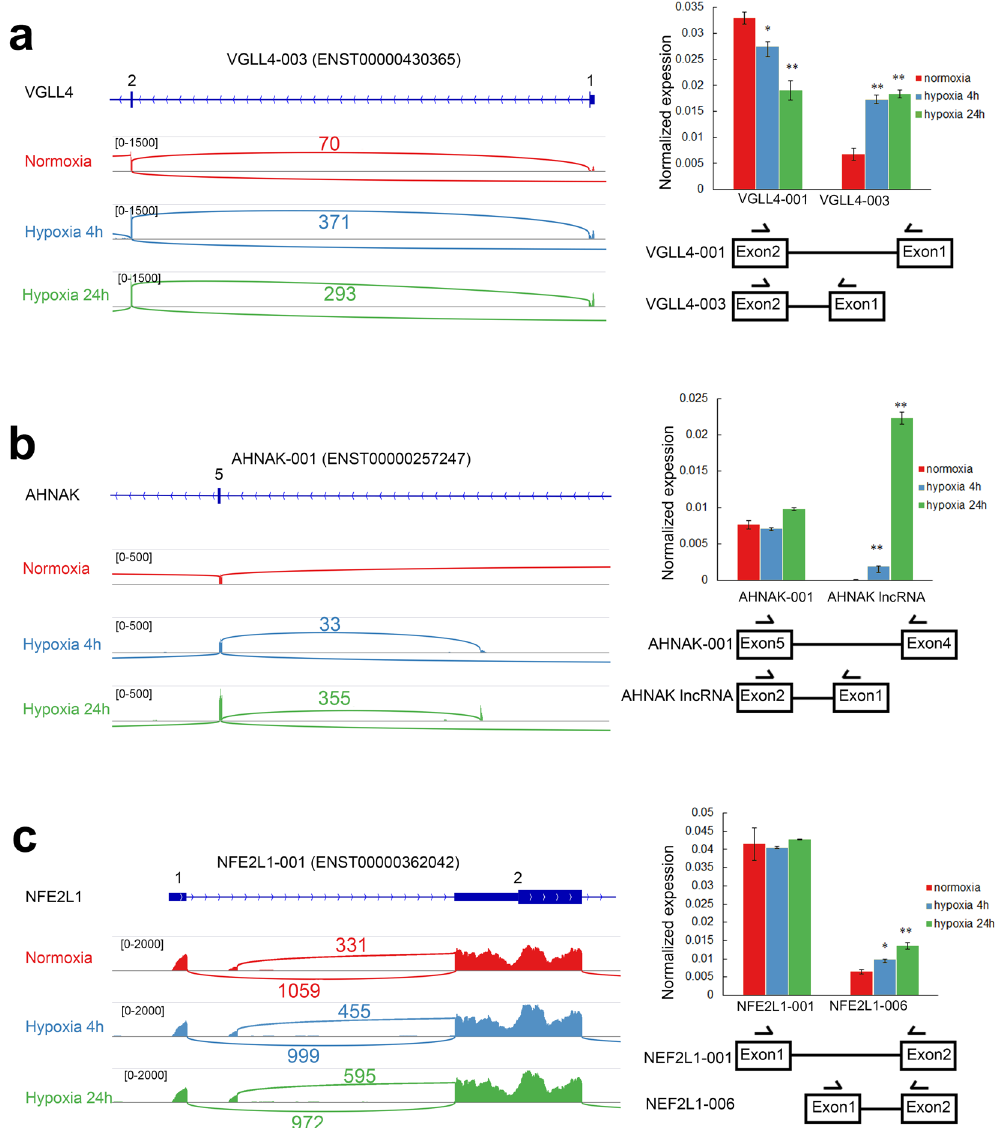
Figure 7. Hypoxia drives alternative first exon usage of VGLL4 , AHNAK and NFE2L1 in MCF7 cells. Normalized RNA-Seq reads in normoxia, acute and chronic hypoxia for n = 1 replicate mapped to ( a ) VGLL4 , ( b ) AHNAK and ( c ) NFE2L1 were displayed using IGV 2.3 in the sashimi plots (left panel). Exon coverage is shown on the same scale for each gene. Numbers indicate exon-exon junction counts. The normalized expression of the alternative first exon isoforms for ( a ) VGLL4 , ( b ) AHNAK and (c) NFE2L1 was measured using qRT-PCR. PPIA expression was used as the housekeeping reference control. The positions of primers used in the qRT-PCR are schematized. All qRT-PCR analysis was performed in three biological (n = 3). Error bars indicate SEM. Statistical significance was evaluated with Student’s t-test. * indicates p-value < 0.05, ** indicates p-value <